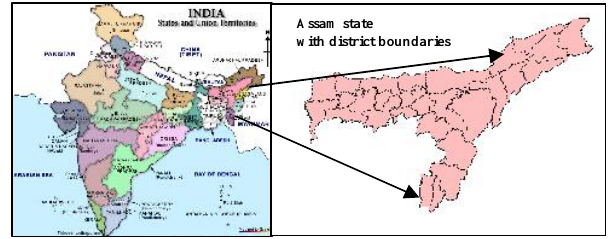
Figure 1. Location of study